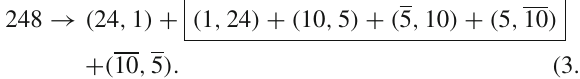
The dominant constraint comes from the muon decay μ − → e − e − e + , with branching ratio bounded as Br (μ → eee ) < 10 − 12 at 90% confidence level